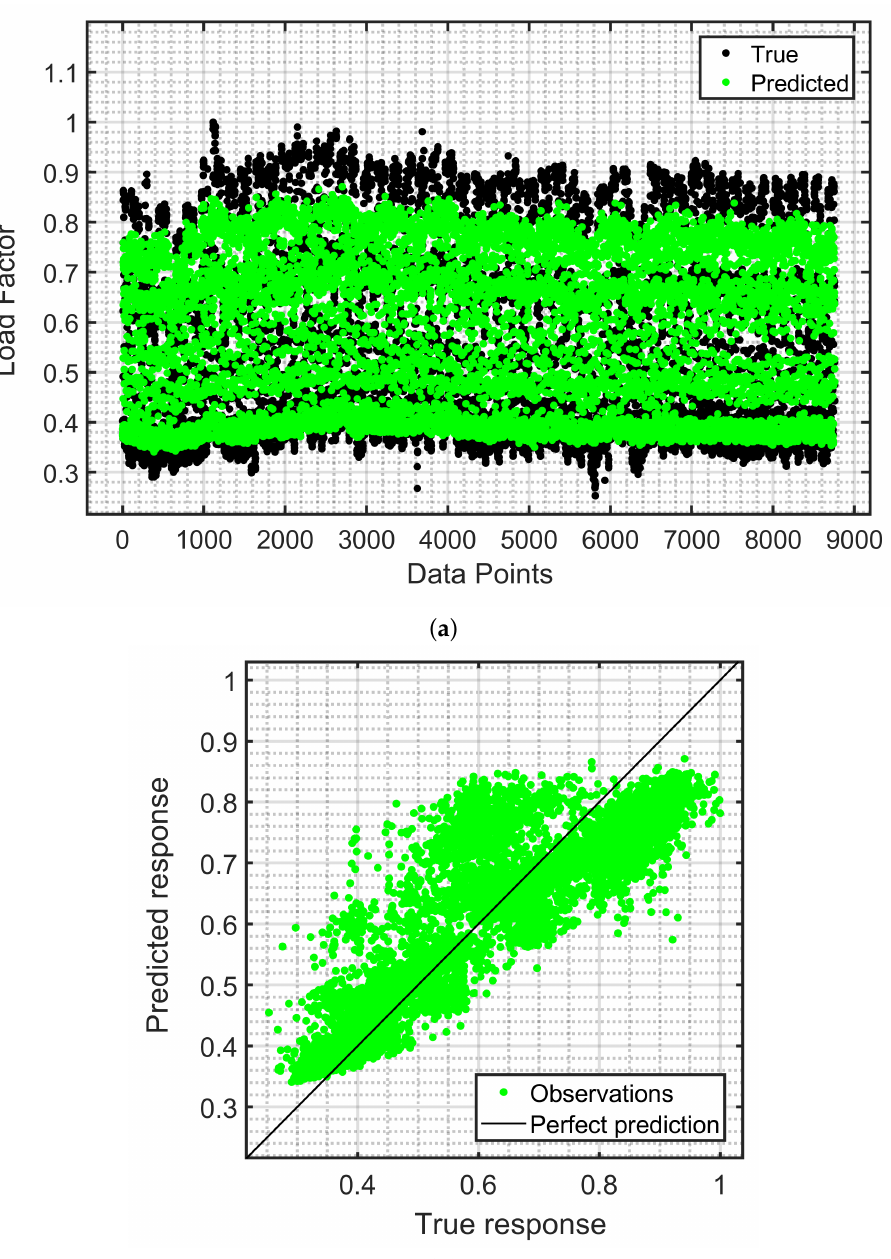
Figure 12. Results with Ensemble. ( a ) Actual versus predicted values of Ensemble. ( b ) Linearity analysis of